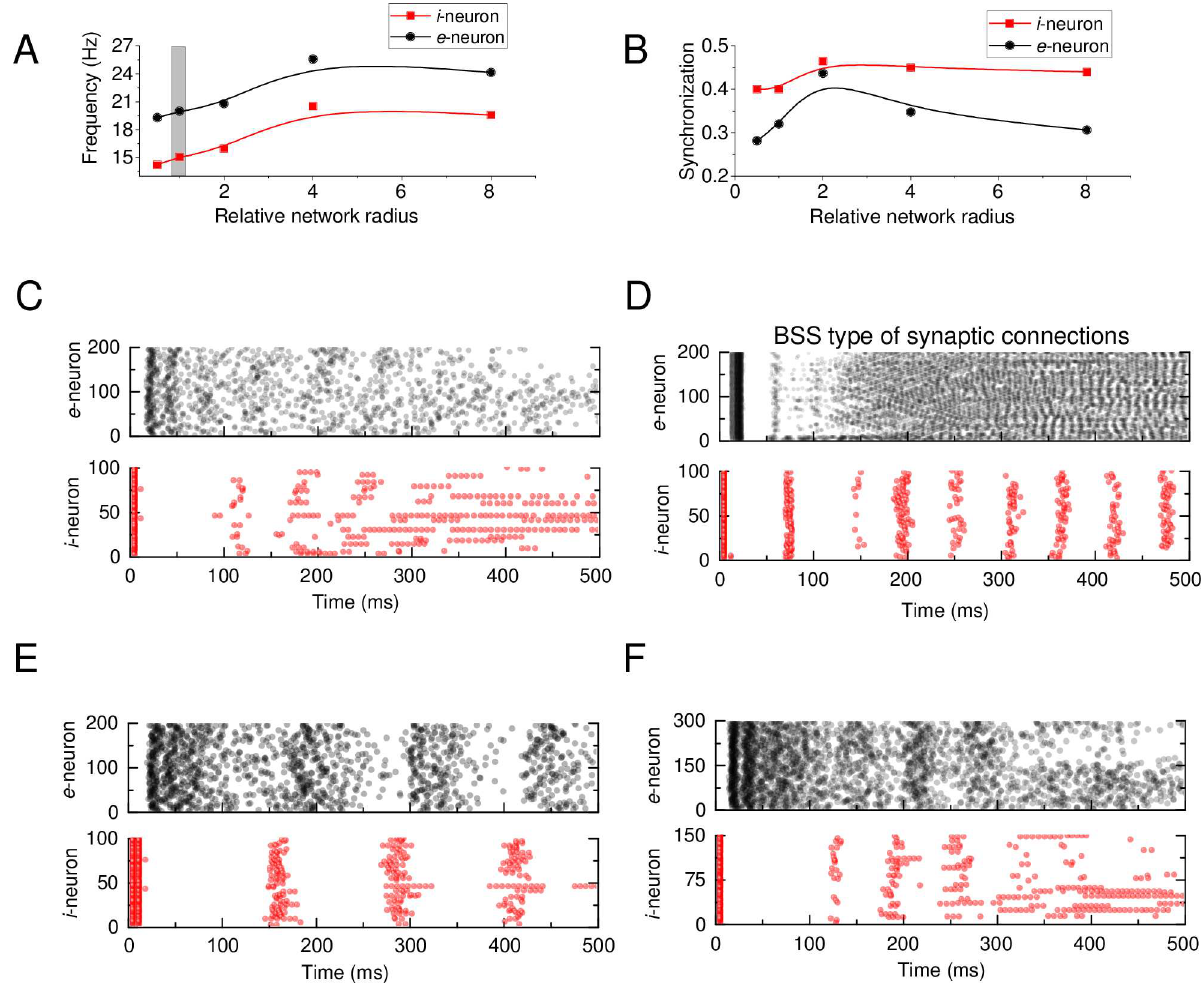
Fig 3. Network organisation versus rhythm genesis and synchronisation. (A-B) Frequency(A) and synchronization (B) indicators versus the relative radiusof e -networkand i -network(relative to their ’reference’radiii 250 μ m and 200 μ m, respectively). (C) Spiking raster plots of the ‘basic-set’(S2 File Biophysical model) networks, includingthe BSD type synaptic weight distribution. (D) Spiking raster plots for ‘basic-set’(S2 File) networks (ratio = 1), but with the BSS type synaptic distribution. (E) Spiking raster plots of ‘basic-set’networks, but with the network radii increasedtwo-fold (corresponds to the abscissa value of 2 in A-B). (F) Spiking raster plots for ‘basic-set’networks, but with the total numbers of both e -neuronsand i -neuronsincreased1.5-fold.